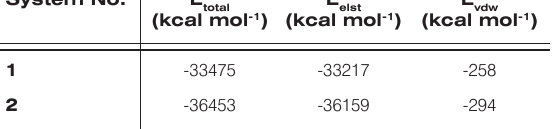
Figure 3. Simulations of two ZnS nanoparticles surrounded by water molecules in tight arrangement (left) and with mutual distance of 2.0 nm. Table 1. Calculated sublimation energies for systems of ZnS nanoparticles and water. System